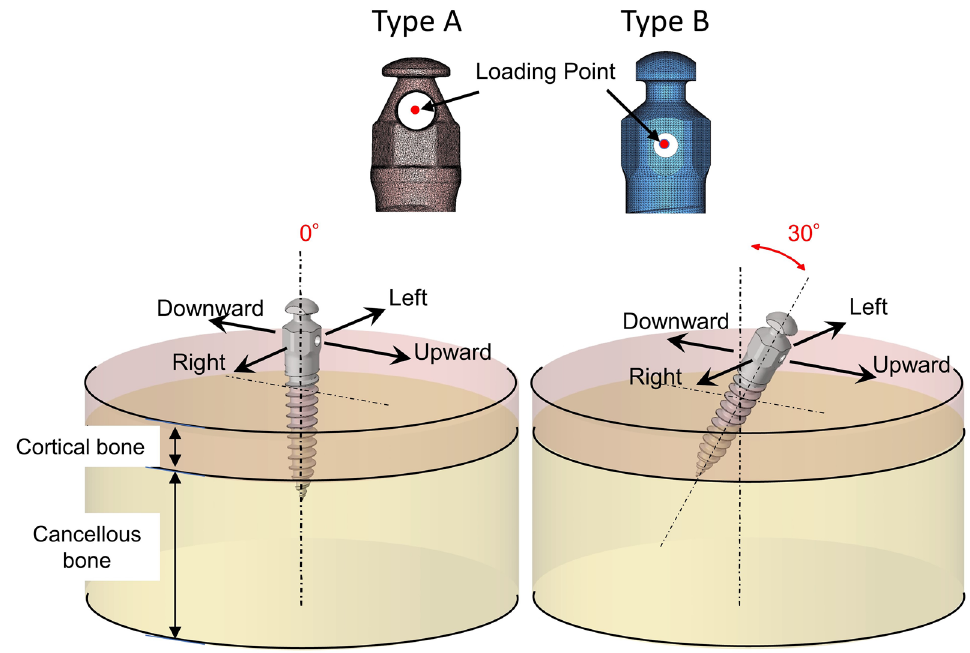
Figure 1. Schematic illustration of 3D finite element models for the evaluated miniscrews. The modeled cortical bone had a thickness of 1.5 mm, 2.0 mm, or 3.0 mm. The orthodontic miniscrews were placed at a direction of 0° or